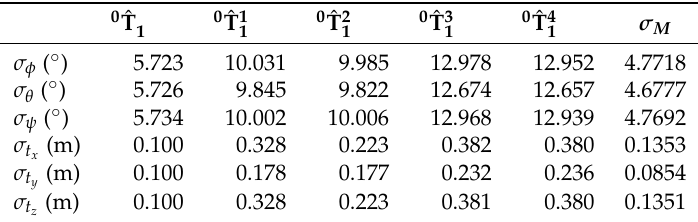
Table 3. Standard deviations of the several posture variables for the transformation paths assuming a Gaussian distribution of errors on all variables with an initial uncertainty of 5.7 ◦ or 0.1